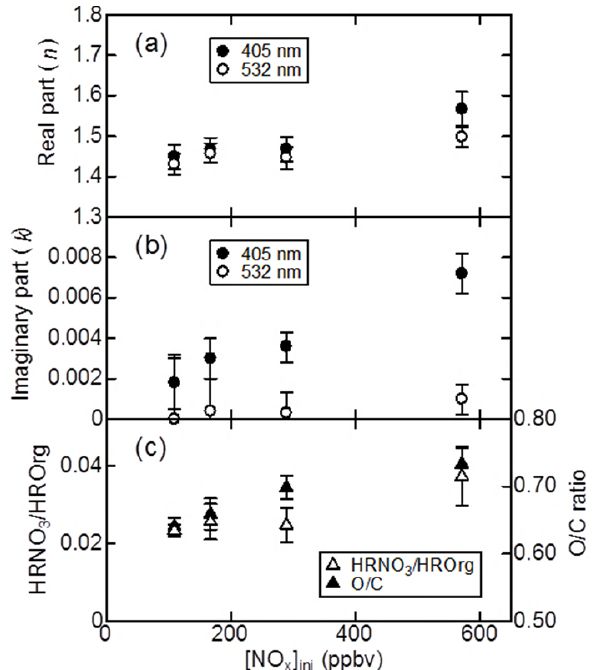
Figure 6. [NO x ] ini dependence of the (a) real and (b) imaginary parts of the RI values at 405 871 Fig. 6. [NO x ] ini dependence of the (a) real and (b) imaginary parts of the RI-values at 405 and 532nm for the toluene-SOAs and (c) and 532 nm for the toluene-SOAs and (c) HRNO 3 /HROrg and O/C ratios measured using 872 HRNO 3 /HROrg and O/C ratios measured using H-TOF-AMS. Er- H-TOF-AMS. Error bars for the n and k values indicate the uncertainties estimated from the 873 ror bars for the n and k -values indicate the uncertainties estimated from the 2 σ values for the differences in the Q ∗ values obtained 2 s values for the differences in the Q* values obtained using eqs. (1) and (2) and those in the 874 using Eqs. (1) and (2) and those in the measurements of the opti- measurements of the optical properties and size distributions of the SOAs, while those in the 875 cal properties and size distributions of the SOAs, while those in the HRNO 3 /HROrg and O/C ratios indicate the 1 σ values of the ratios HRNO 3 /HROrg and O/C ratios indicate the 1 s values of the ratios during the periods used for 876 during the periods used for determination of the determination of the RI values. 877